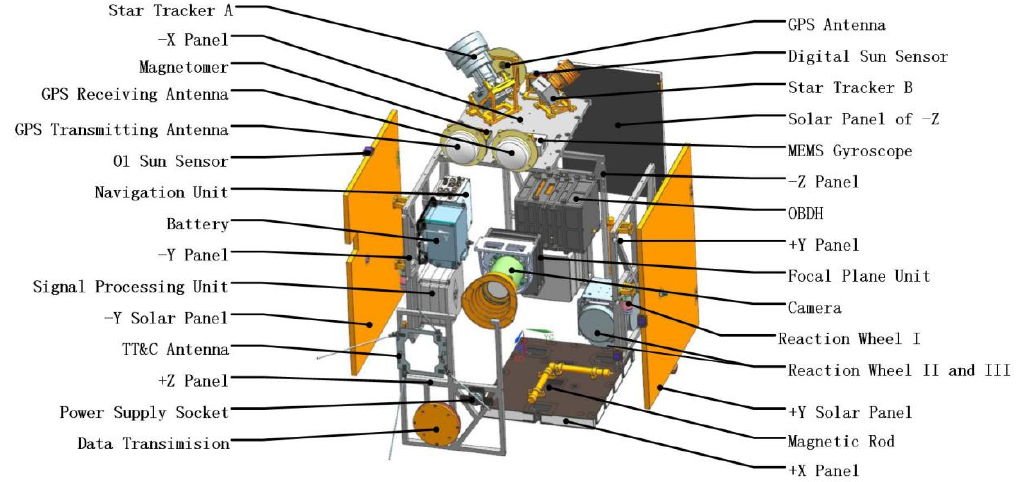
Figure 2. Exploded view of the Luojia 1-01 Satellite.